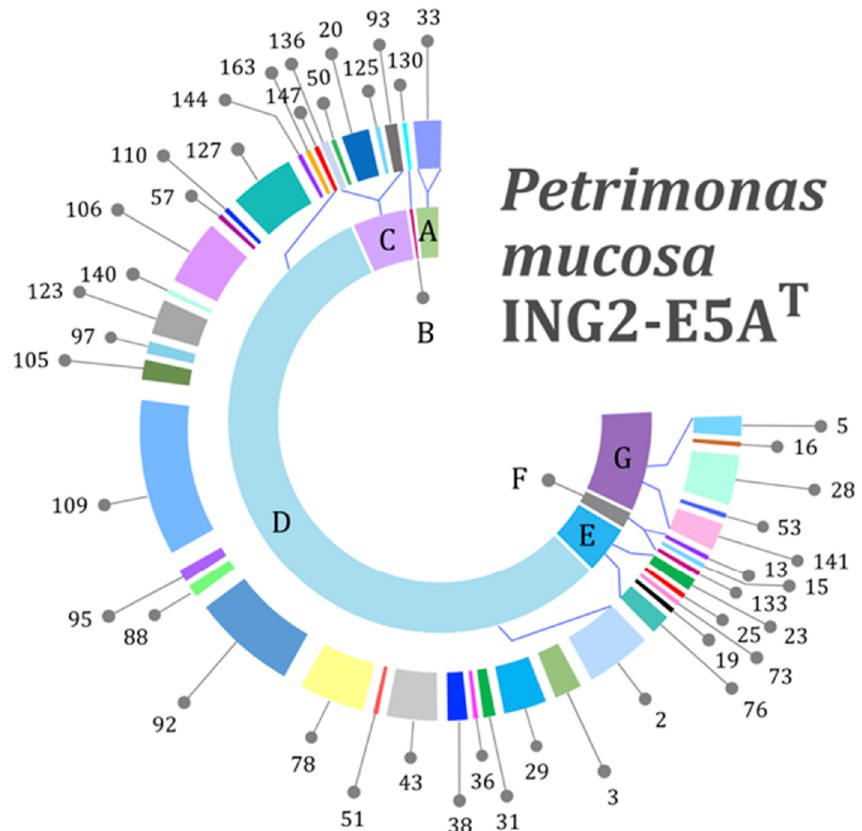
Figure 3. P. mucosa ING2-E5A T genes encoding for di ff erent glycoside hydrolases (GH) predicted to be involved in carbohydrate utilization as checked manually with the Carbohydrate Active Enzymes (CAZy) database (http: // www.cazy.org / ). The outer ring represents the diversity of the GH families identified in the genome of the strain ING2-E5A T . The inner ring indicates the predicted function of the respective GH family as follows: A: Exo- α -sialidases, B: oligosaccharide phosphorylase, C: glycosidases (hydrolysis of single sugar residues), D: glycosidases (hydrolysis of single sugar residues from nonreducing ends), E: cell wall degradation, F: starch and glycogen hydrolases, G: heteropolymers and polysaccharides including hemicellulose.